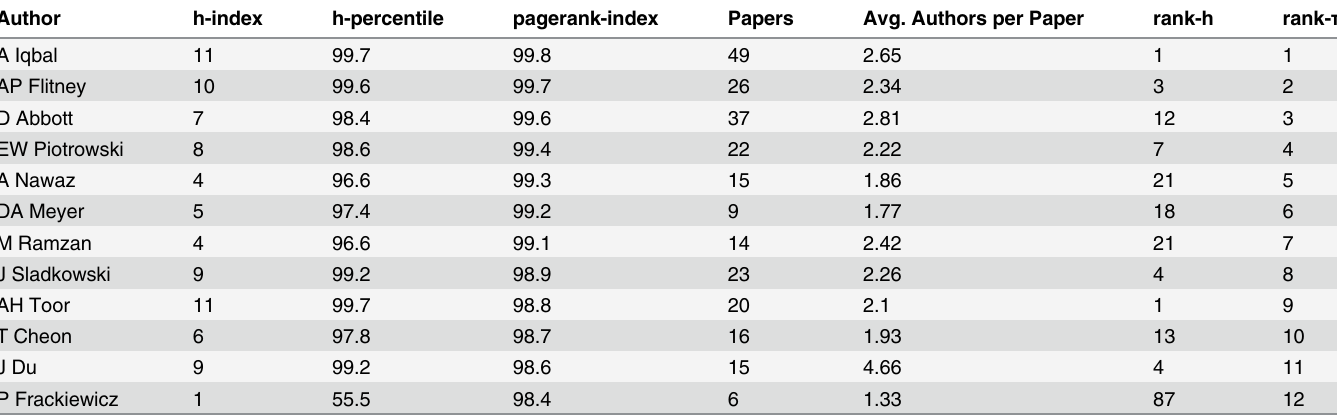
Table 2. The top 12 scientists as ordered by their pagerank-index in the field of quantum game